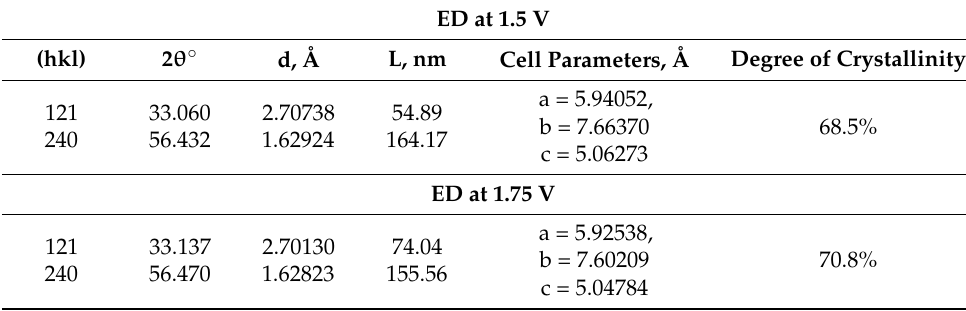
Figure 4. XRD after ED at 1.5 V ( a ) and 1.75 V ( b ). Table 3. XRD results of ED samples.